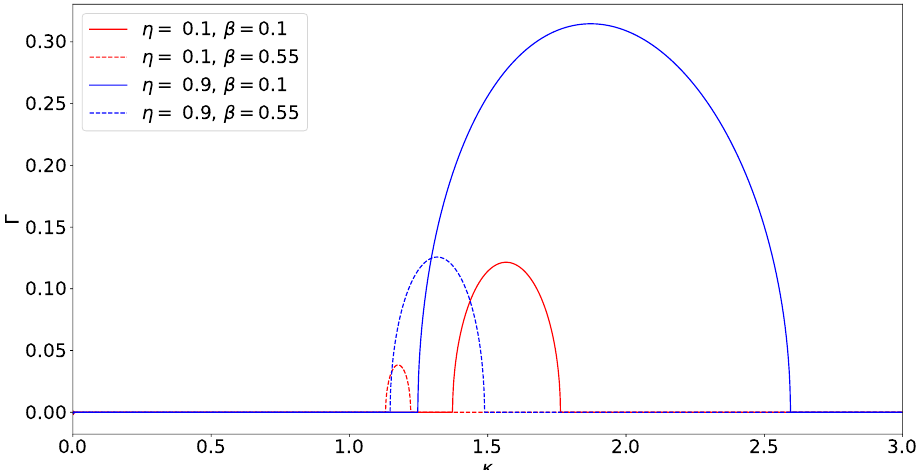
Figure 6. Growth rate Γ as a function of the normalized wavenumber κ for various values of the pump wave amplitude η and plasma β obtained from the solution of the dispersion relation